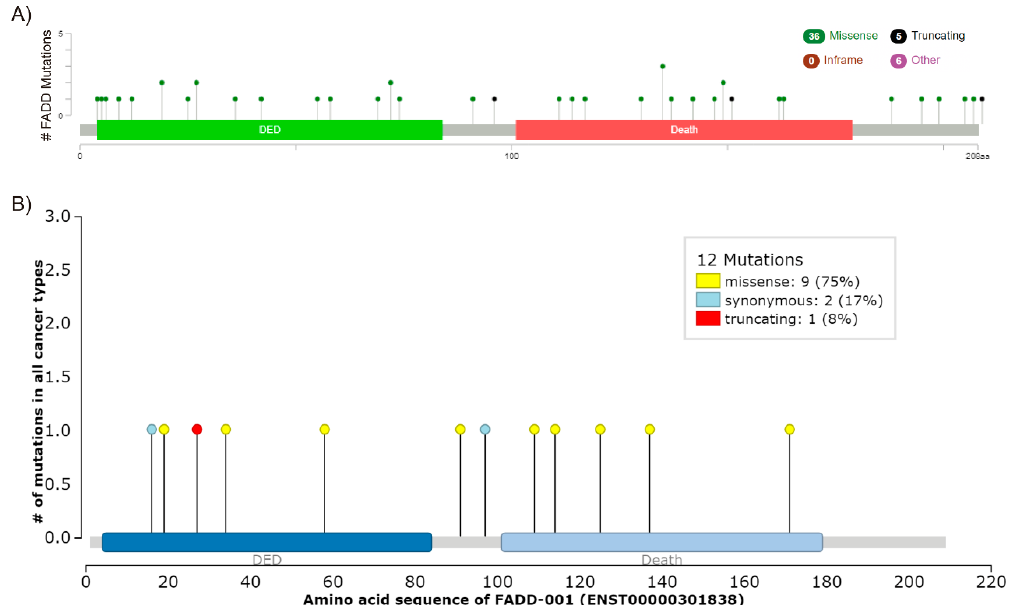
Figure 4. FADD mutations. ( A ) Screenshot modified from cBioPortal. Mutation diagram circles are colored with respect to the corresponding mutation types. In case of different mutation types at a single position, the color of the circle is determined with respect to the most frequent mutation type. ( B ) Screenshot image modified from IntOGen. The mutations needle plot shows the distribution of the observed cancer mutations along the protein sequence and its possible mutational clusters and hotspots. The needles’ height and head size represent mutational recurrence. Needles of different categories that fall in the same amino acid residues are stacked.